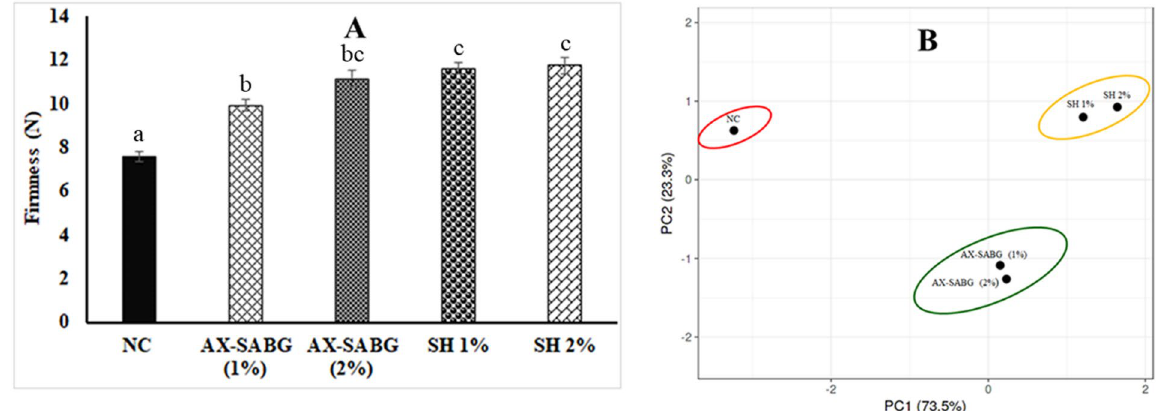
Figure 3. (A) Change in firmness and (B) PCA of correlation between different properties of peaches during storage ( NC uncoated, AX‑SABG arabinoxylan-β-d-glucan stearic acid ester, SH shellac). Data were analysed using ANOVA followed by Tukey’s multiple comparisons tests. The letters compare changes between the treatments. Different letters indicate significant differences at p < 0.05.